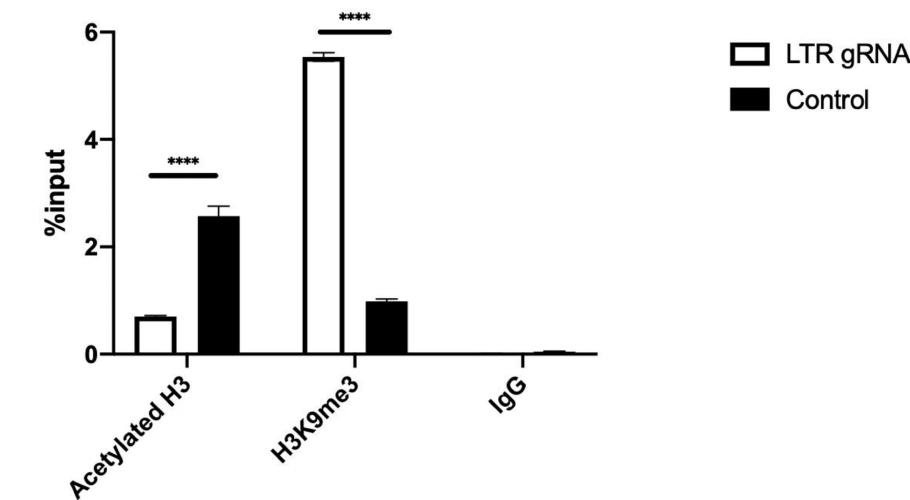
Figure 4. dCas9-KRAB mediates post-translational modification of histones that correlate with transcriptional repression. HEK 293T cells were infected with pseudotyped NL4-3-env-Luciferase and 24 hours later transfected in duplicate with dCas9-KRAB construct and gRNA targeting the HIV LTR (397) or a scrambled control. Forty-eight hours post transfection, ChIPs were performed using anti-acH3 and anti-H3K9me3 antibodies. Associated HIV-1 LTR sequences were detected by PCR. These data represent a single experiment of 3 independent experiments (see Figure S2). Error bars represent standard deviation, and a student t -test was performed for statistical significance. **** indicates p <